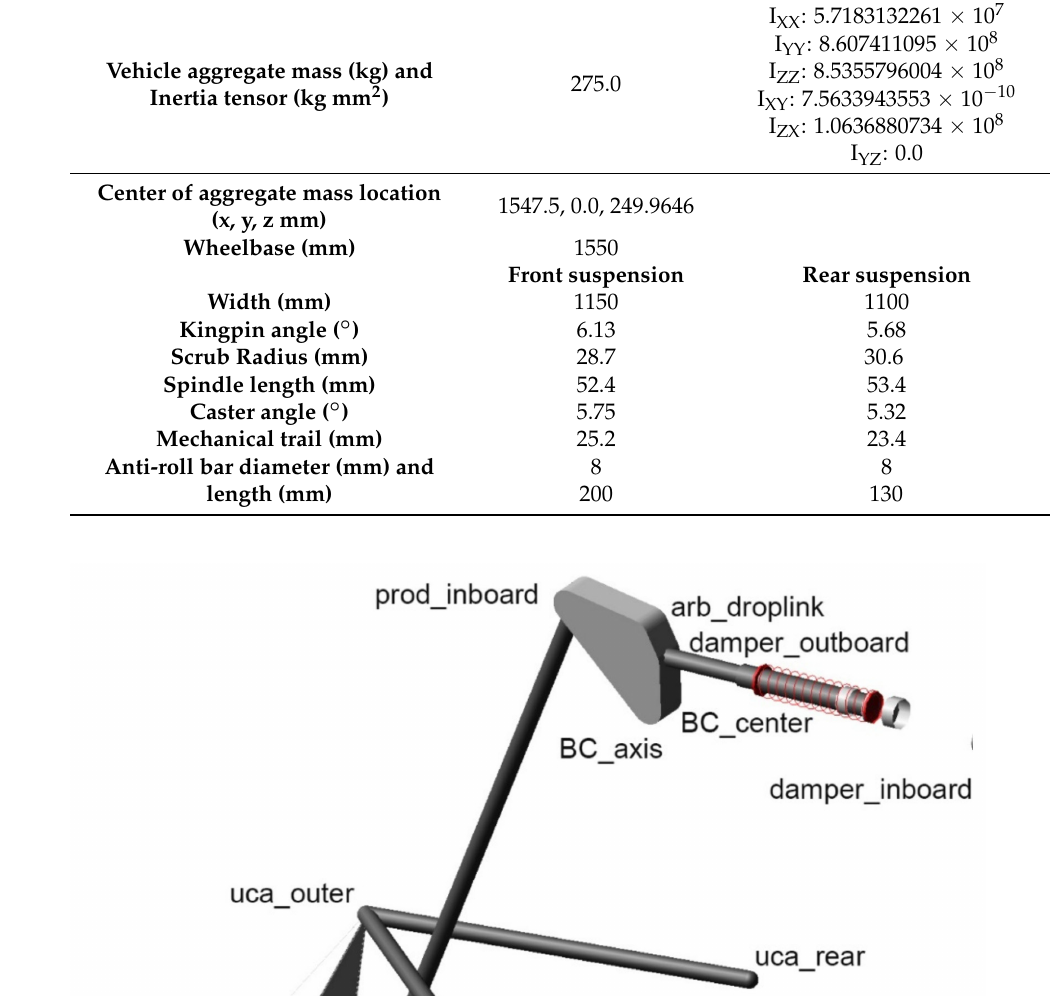
Table A1. General specifications of the Formula Student car.